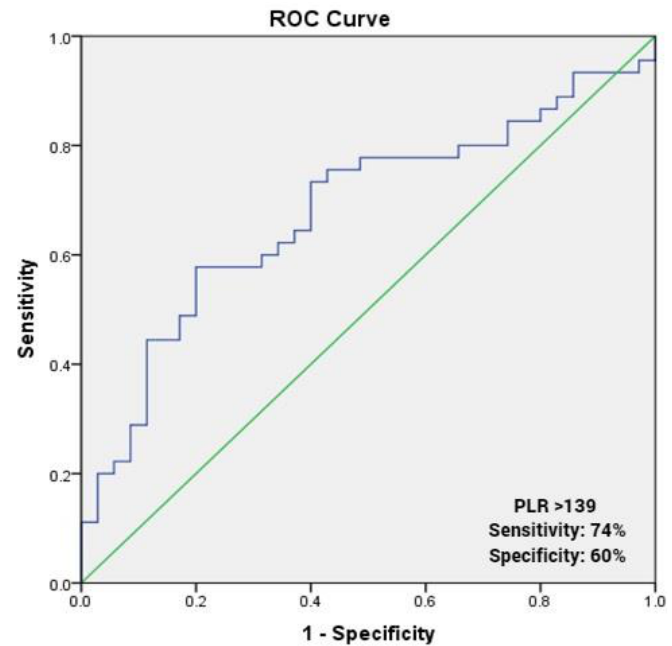
Figure 3. Receiver operating characteristic curve of platelet to lymphocyte ratio for predicting poor functional